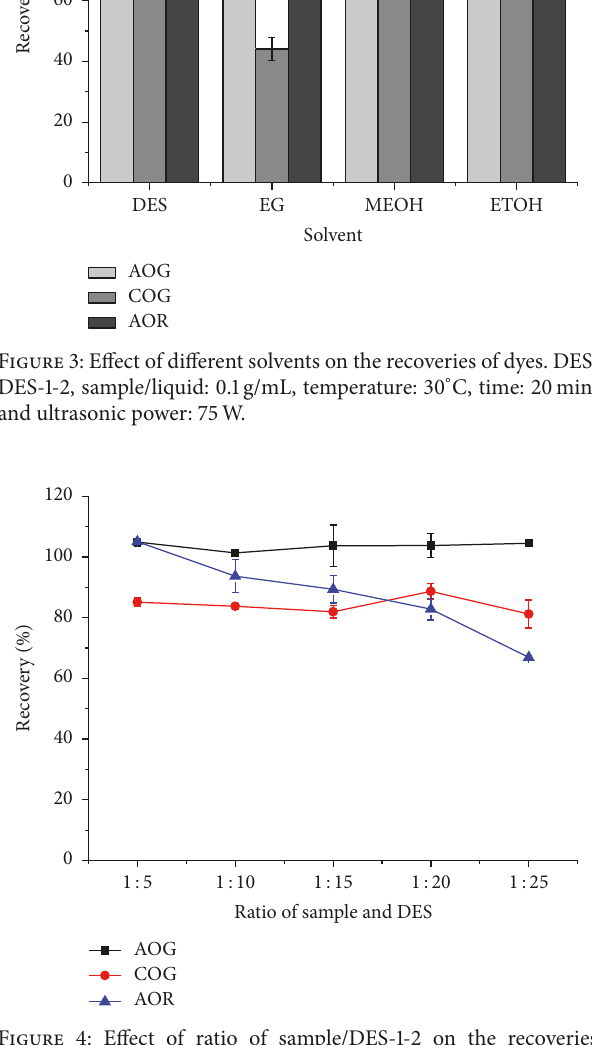
Figure 4: Effect of ratio of sample/DES-1-2 on the recoveries of COG, AOG, and AOR. Temperature: 30 ∘ C, time: 20 min, and ultrasonic power: 75